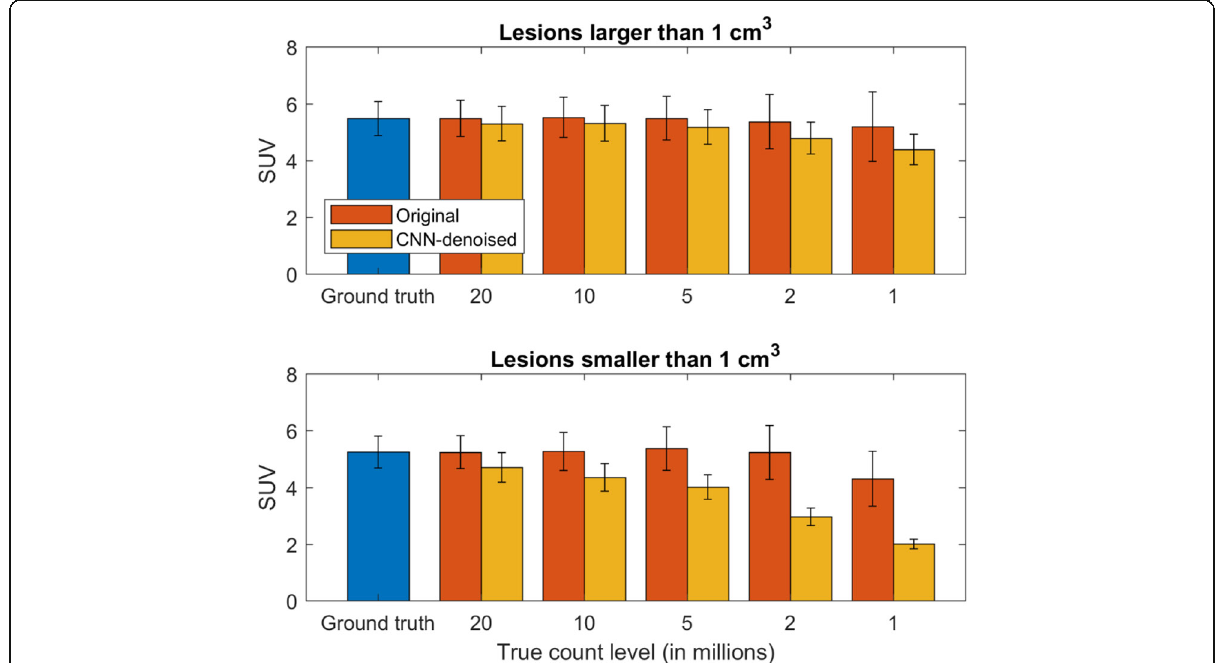
Fig. 3 Mean SUV measurements in VOI ’ s contoured for 65 lesions, grouped by those with volumes larger and smaller than 1 cm 3 . The CNN had difficulty to accurately quantify lesion SUVs, and this effect was amplified for small lesions in noisy data. Error bars denote the